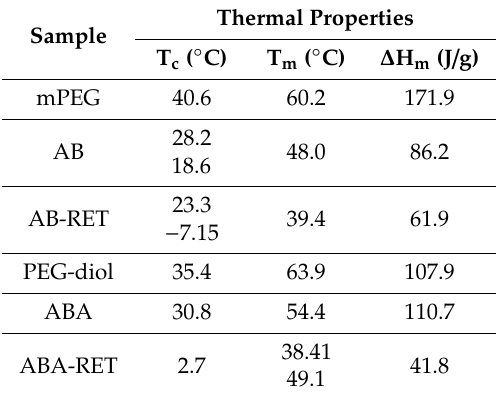
Figure 3. DSC traces for a representative set of materials: PEG-diol, PLC-b-PEG-b-PCL (ABA and its corresponding conjugate ABA-RET). Cooling ( A ) and heating ( B ). Thermal properties of the polymeric materials measured by di ff erential scanning calorimeter (DSC).